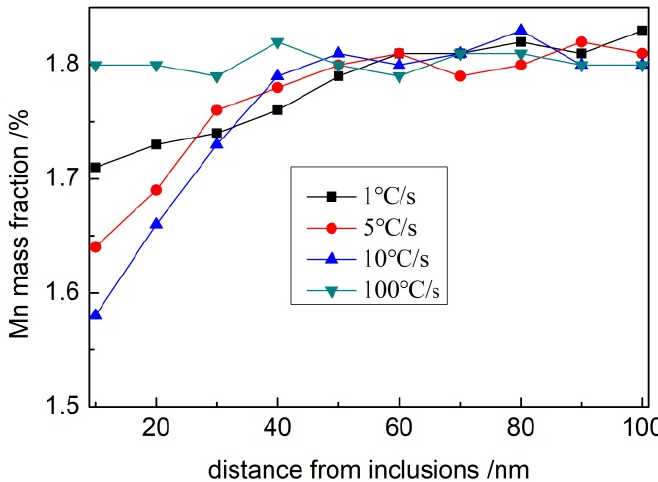
Figure 7. Concentration distribution of Mn around inclusions in the weld metal.